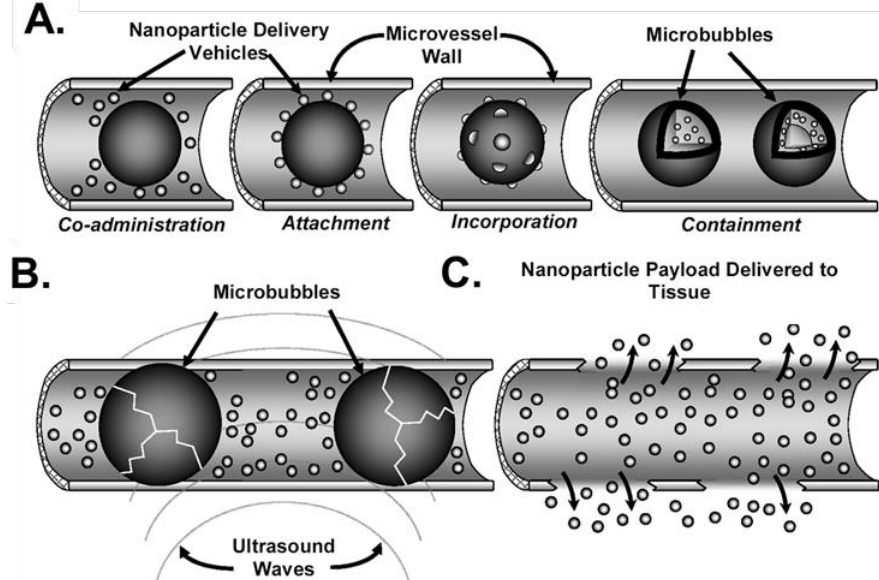
Figure 2. Overview of approaches to US + MB-mediated drug and/or gene delivery. ( A ) The therapeutic agent (nanoparticles in this example) may be co-administered with contrast agent microbubbles, attached to microbubble shells, incorporated into the microbubble shell, and/or contained within the microbubble. ( B ) The application of US activates the oscillation of microbubbles. At high enough peak-negative acoustic pressures, microbubbles can be fragmented. In some approaches, microbubble activation may lead to dissociation of a bound therapeutic from the microbubble. ( C ) Ultrasound–microbubble interactions simultaneously act to permeabilize the surrounding microvasculature, facilitating delivery of the therapeutic via diffusion and/or convection from the bloodstream to the ultrasound-targeted tissue. Adapted from Chappell and Price. [98].